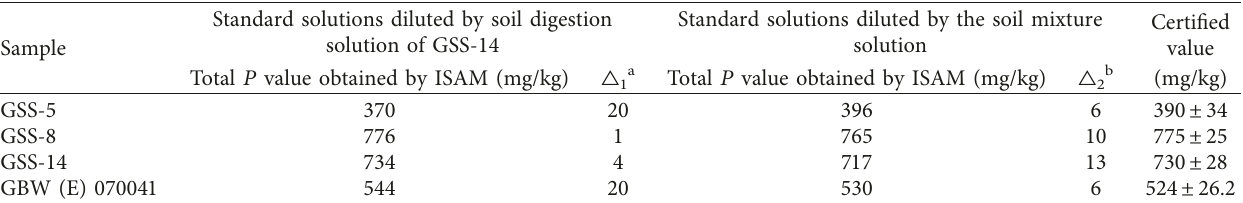
Figure 1: Procedure of analysis by ISAM. Table 5: Comparison of the determined results of total P by ISAM with standard solutions diluted by soil digestion solution of GSS-14 and by the soil mixture